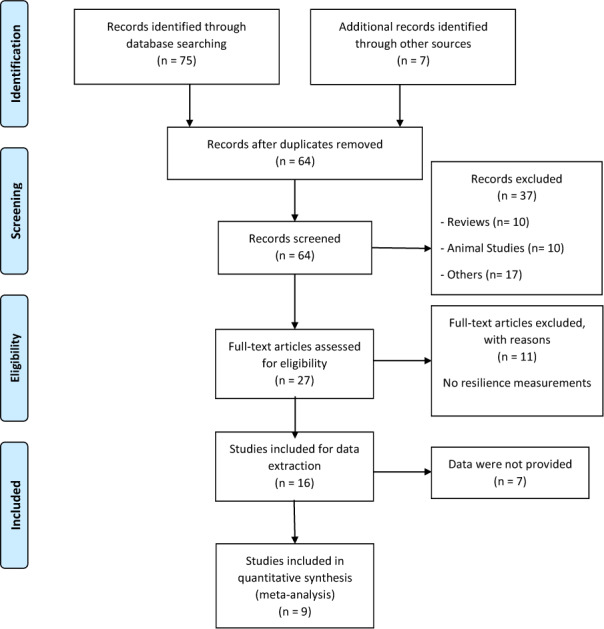
PRISMA flow diagram